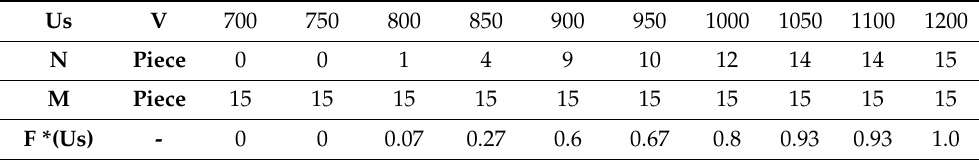
Table 3. Results of the sensitivity test of lamp B on surge impulse 1.2/50 µ